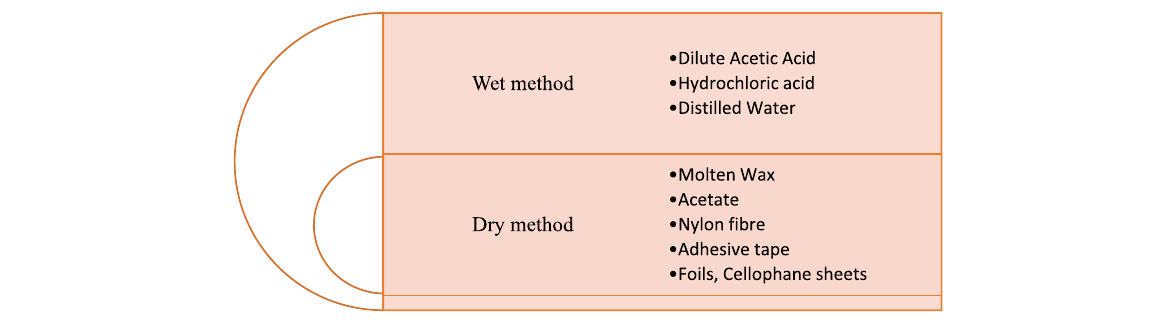
Fig. 1 Types of collection method for gunshot